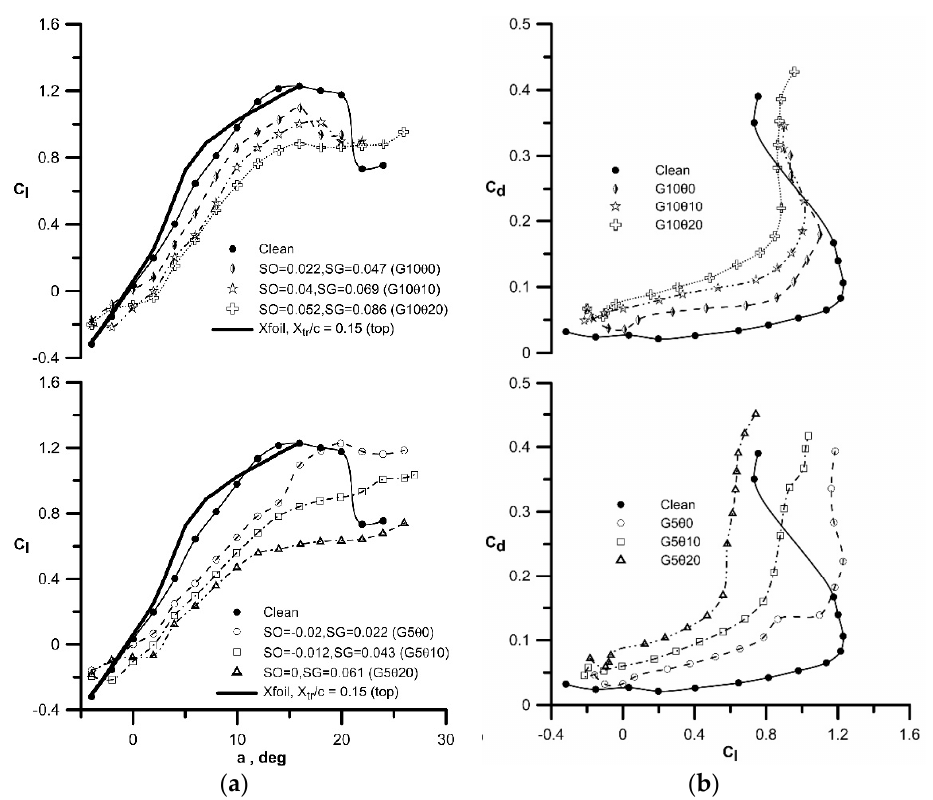
Figure 7. Effect of slat gap and angle on the ( a ) measured lift coefficient and ( b ) profile drag coefficient with side plates installed.